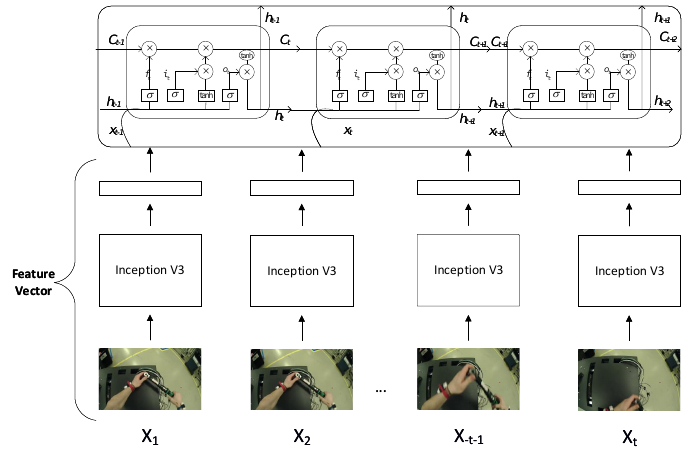
Figure 7. Extracting the spatial features from the CNN and feeding them to the recurrent neural network (RNN) (long short-term memory (LSTM)) with